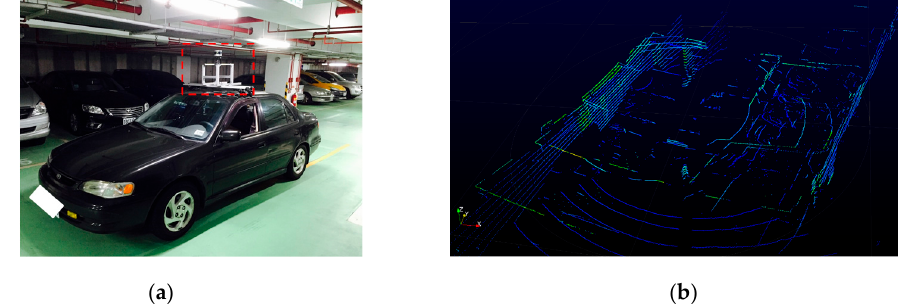
Figure 12. The aluminum extrusion support frame and a cloud deck of the LiDAR system. ( a ) Actual setup of the LiDAR. ( b ) On-site LiDAR point cloud.